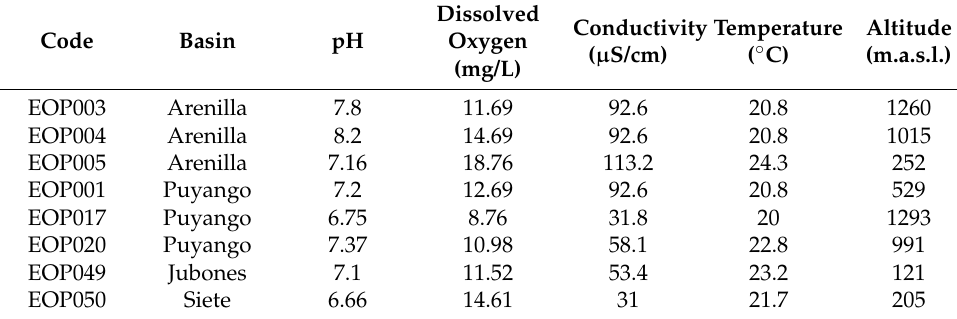
Table 1. Environmental characteristics of the studied